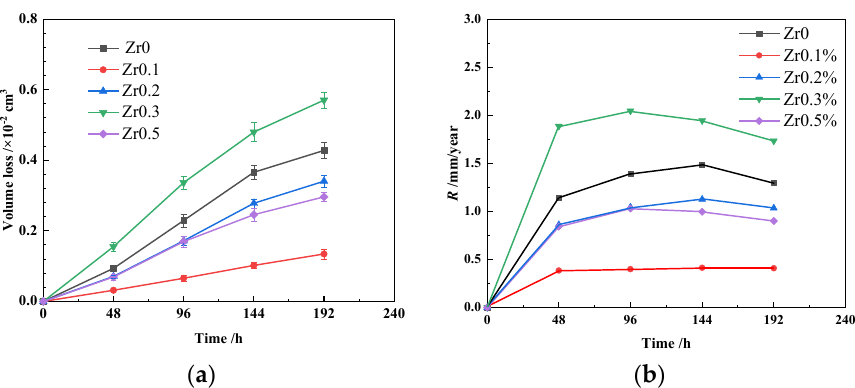
Figure 1. Volume loss ( a ) and the average corrosion rates ( b ) of as-cast AlCoCrFeNiZr x alloys in a 0.5 M H 2 SO 4 solution for the 0–192 h immersion tests at 25 °C.